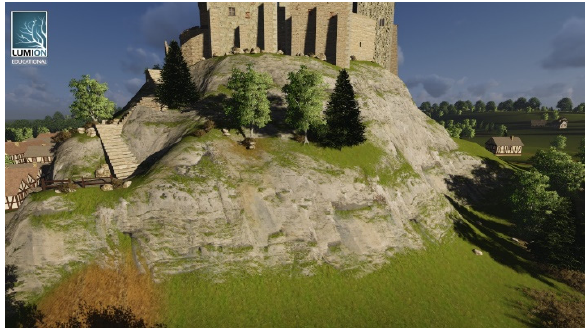
Figure 7. Landscape with rock, grass and trees on the west side